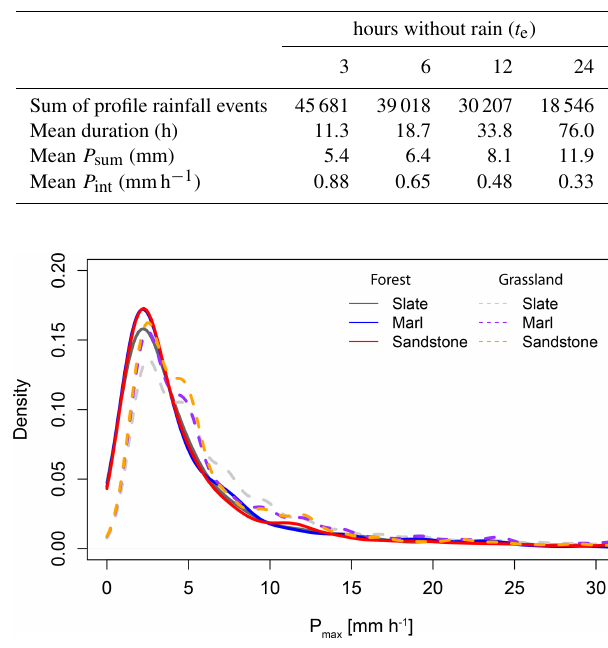
Figure 3. Density distribution of maximum rainfall intensity for the six landscape